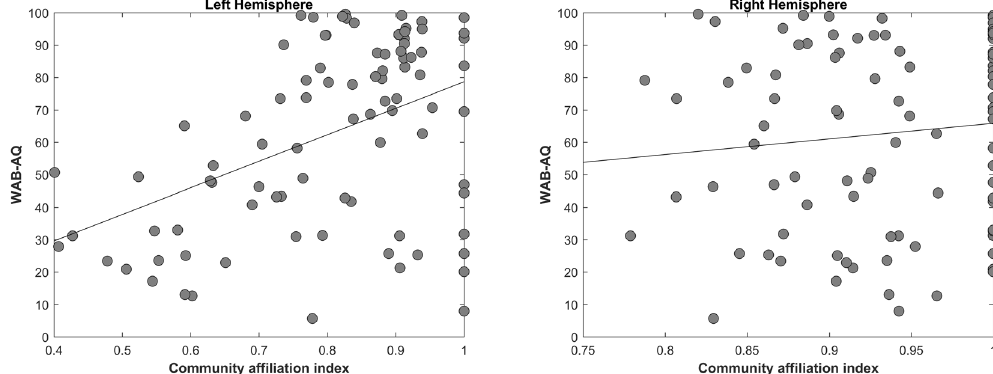
Figure 3. Correlation between community affiliation index (C) and aphasia severity. Left Hemisphere (r = 0.4438, p < 0.00001), Right Hemisphere (r = 0.12, p = 0.3144).